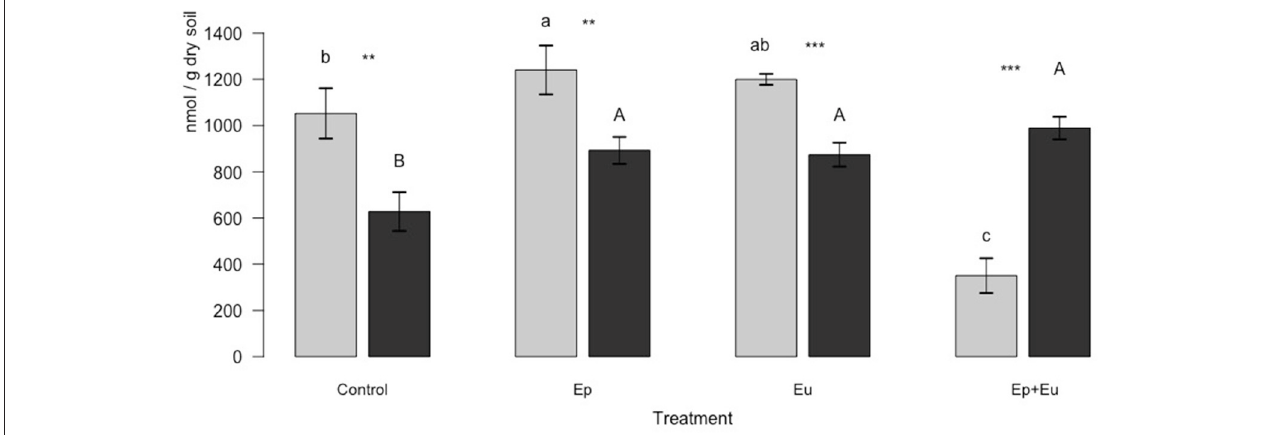
FIGURE 1 | Total PLFA (mean ± standard deviation) of four experimental treatments 1 and 2 months after Collembola re-inoculation. Gray bar-plot = first month, black bar-plot = second month. Different minuscule letters (i.e., “a”, “b”, “c”) indicate significant differences ( α = 0.05) between treatments for first month. Different capital letters (i.e., “A,” “B”) indicate significant differences ( α = 0.05) between treatments for second month. The asterisks indicate significant differences between the months for a given treatment (*** p < 0.001, ** p < 0.01). Control, without Collembola; Ep, Epedaphic Collembola; Eu, Euedaphic Collembola; Ep + Eu, mixed functional groups ( n = 4).